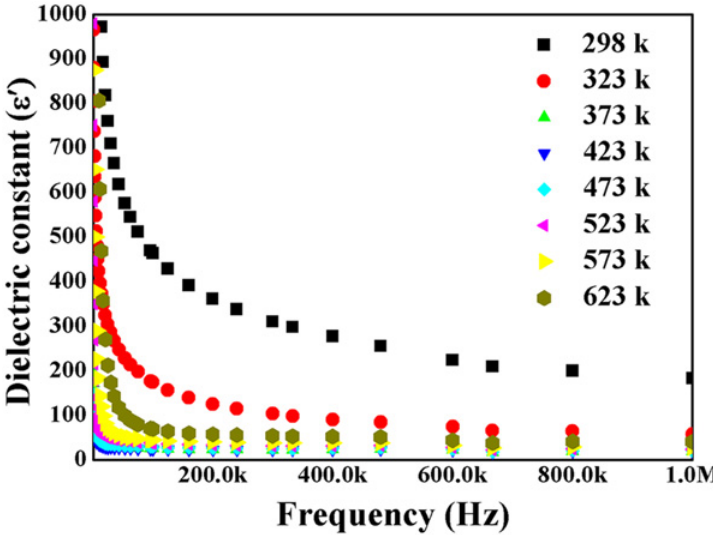
Fig 6. The dielectric constant of the CeO 2 nanopowder versus frequency at various